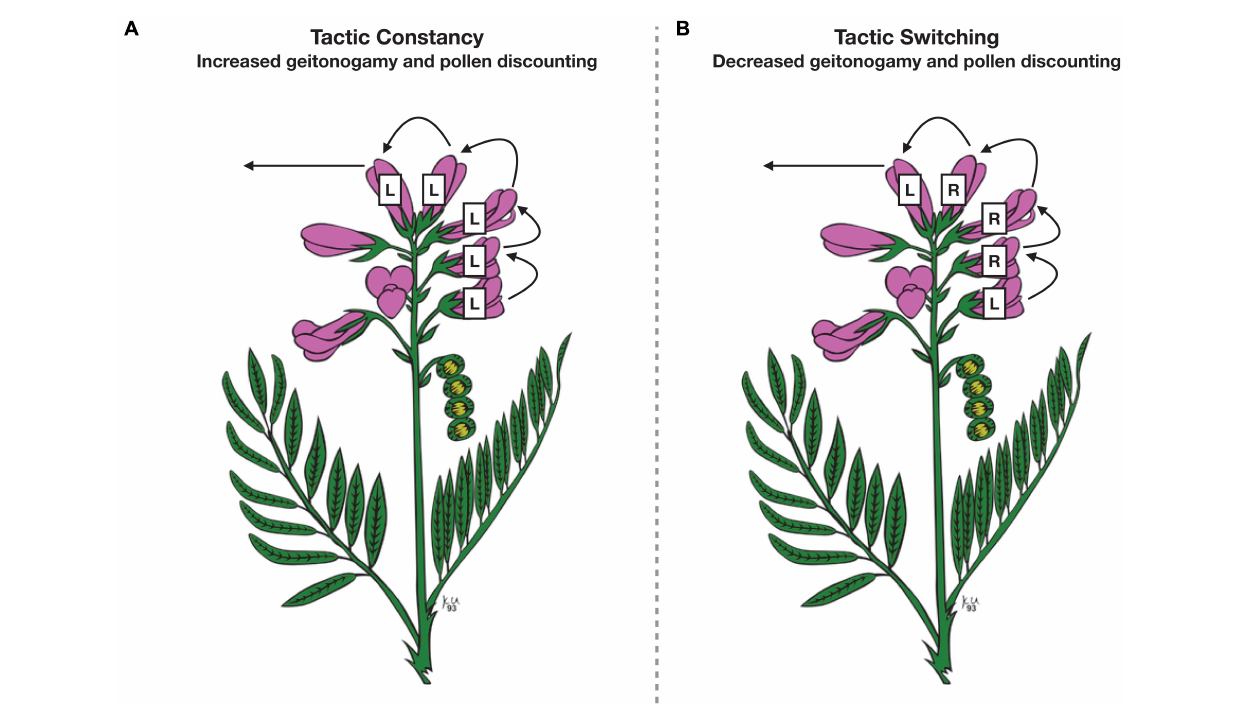
FIGURE 2 | Hypothesized effects of tactic constancy vs. tactic switching on pollen flow. Each panel shows a visitation pattern of a floral forager; flowers labeled “L” receive legitimate foraging visits and flowers labeled “R” receive robbing visits (primary or secondary). Floral visitors that remain constant to legitimate foraging (A) have a higher potential of depositing geitonogamous self-pollen, which can lead to increased pollen discounting. Floral visitors that switch between legitimate foraging and nectar robbing (B) bypass the stigmas of more flowers per plant than a constant legitimate forager, reducing the potential of depositing geitonogamous self-pollen and of pollen discounting. Flower drawing by K. Urban, available under Creative Commons licensing.